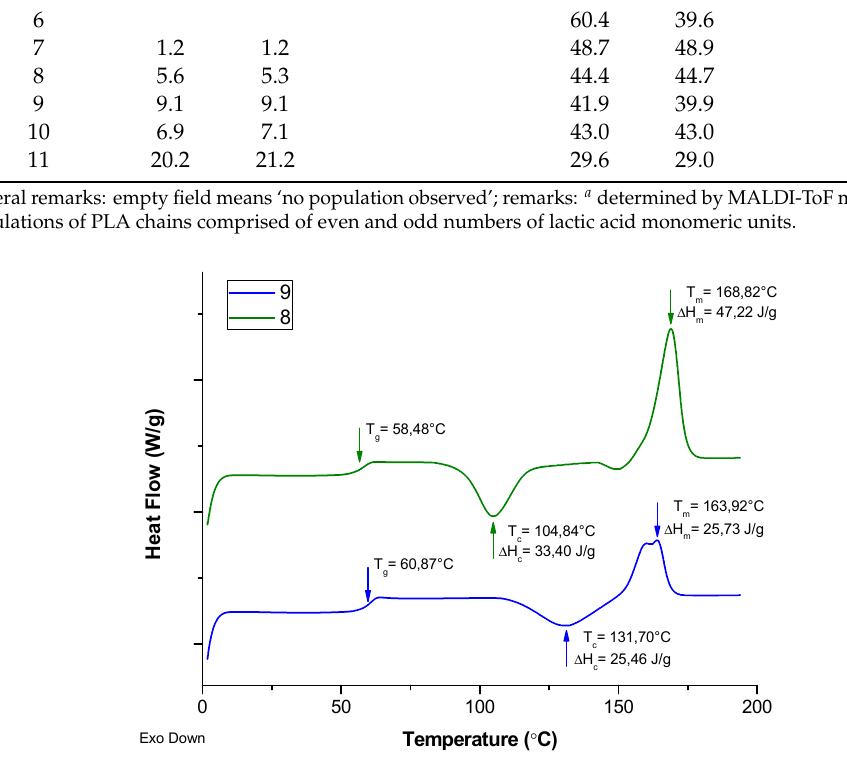
Figure 10. DSC curves of second heating cycle for products no. 8 and 9 (corresp. to Table 1). The 1 H NMR spectra with proton signals assigned to the structures of exemplary oligomeric conjugates PLA-10-DR1 and PLA-10-DR13 are shown in Figures 11 and 12. The spectra showed the expected chain ends: resonances due to dye molecules (denoted as red letters D–K) and a hydroxyl group (blue letter A). The most intensive signals are multiplets at 5.04 ppm (blue B 3 ) and 1.33 ppm (blue C 3 ), corresponding to methine (CH) and methyl (CH 3 ) groups, respectively. These groups are present in the oligolactide, which consists of eight repeating units. The adequate multiplets denoted as B 1 , B 2 at 4.12, 4.89 ppm correspond to CH. Doublets marked as C 1 , C 2 at 1.41, 1.06 ppm are for CH 3 , which refer to the unit located in the vicinity of the hydroxyl chain end. Quartets (B 4 , B 5 at range 5.12–5.07 ppm) and doublets (C 4 , C 5 at 1.36, 1.39 ppm) correspond to the unit located next to the dye chain